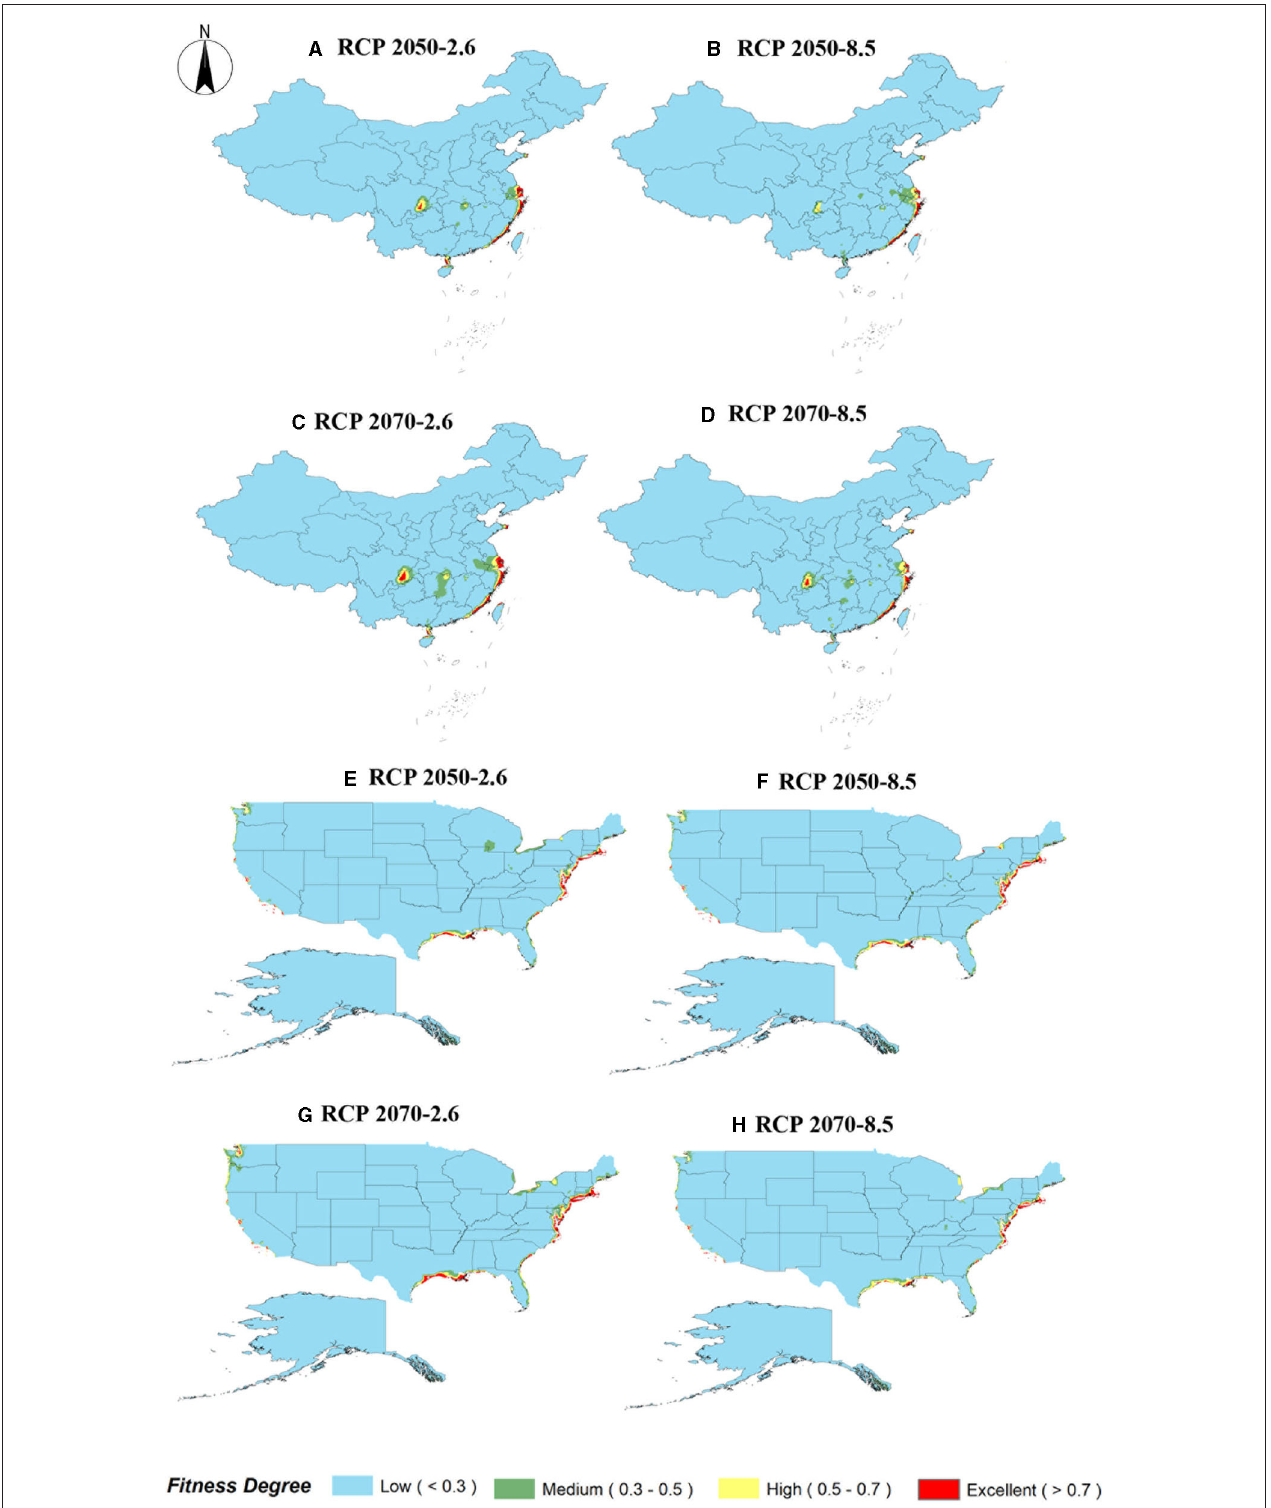
FIGURE 6 | Future species distribution models of S. alterniflora in China and America under different climate scenarios predicted by MaxEnt. (A–D) RCP 2050-2.6 in China; RCP 2050-8.5 in China; RCP 2070-2.6 in China; RCP 2070-8.5 in China; (E–H) RCP 2050-2.6 in America; RCP 2050-8.5 in America; RCP 2070-2.6 in America; RCP 2070-8.5 in